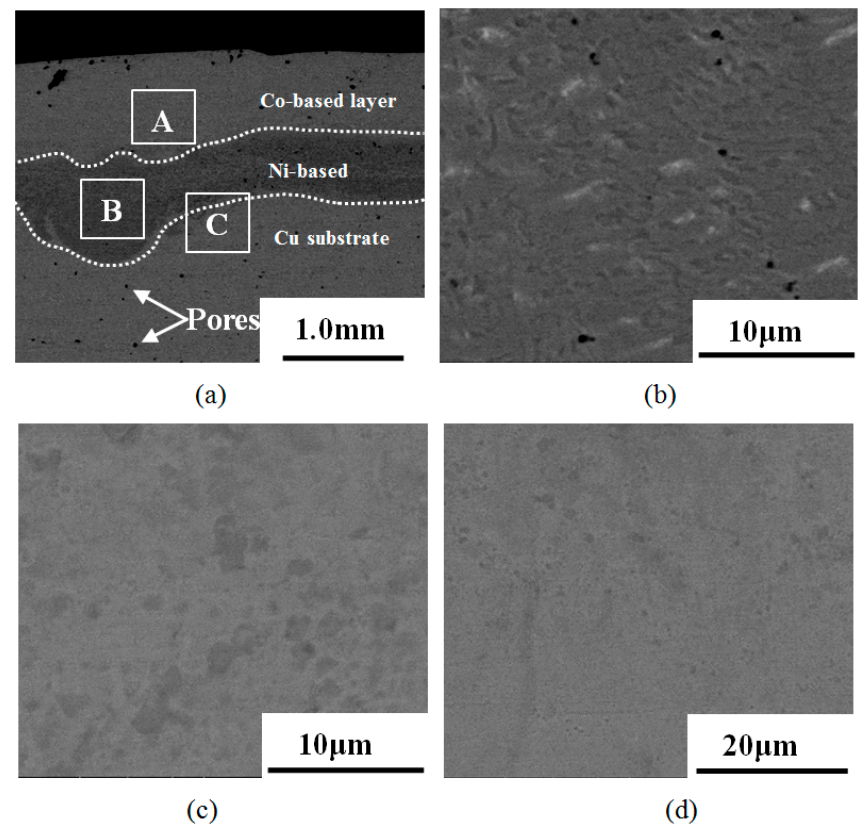
Figure 3. ( a ) Two layers coating; ( b ) Co-based layer; ( c ) Ni-based layer; ( d ) Ni-Cu zone cross-section microstructure morphologies.